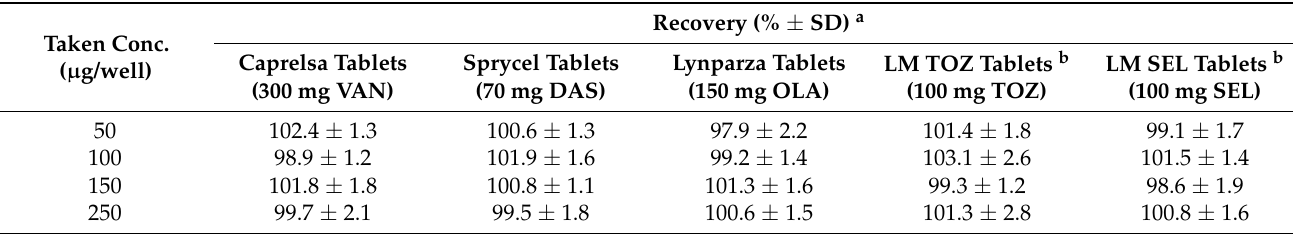
Table 8. Determination of TKIs in their pharmaceutical formulations by the proposed MW-SPA based on their CT reaction with CLA. Taken